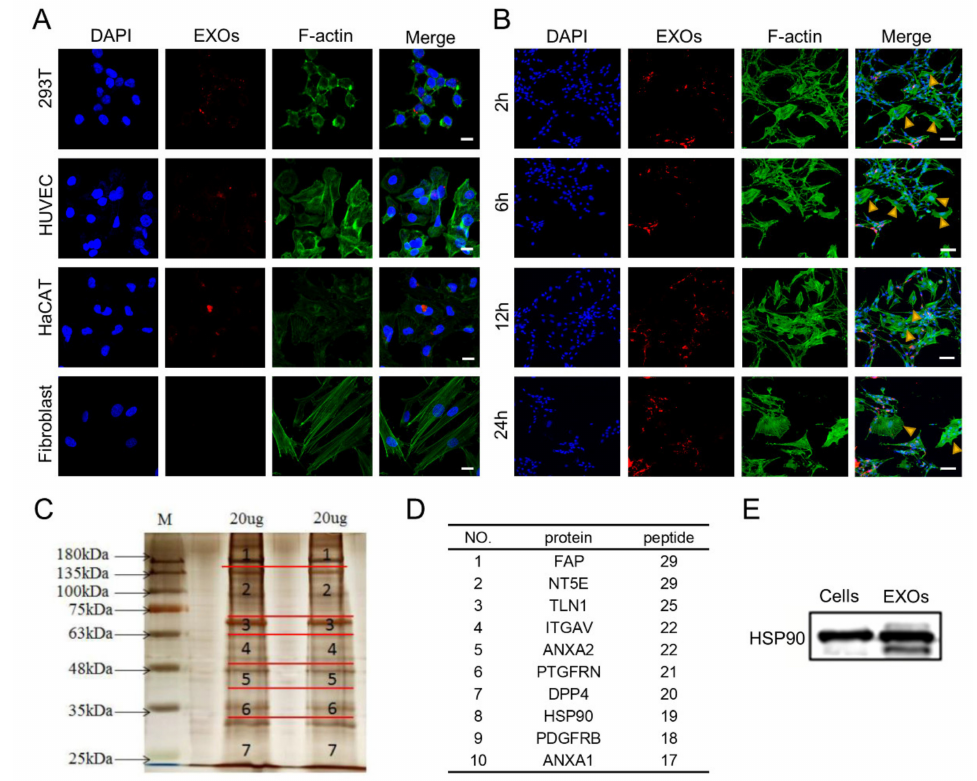
Figure 2. Internalization and protein analysis of ADSC-EXOs. ( A ) Confocal images of 293T, HaCAT, HUVECs, and fibroblasts incubated with 20 µ g PKH26-labeled ADSC-EXOs for 24 h; scale bar: 20 µ m. ( B ) Confocal images of co-cultured Schwann cells and fibroblasts incubated with PKH26-labeled ADSC-EXOs at different times; scale bar: 100 µ m. ( C ) Silver staining analysis of ADSC-EXOs protein gels. ( D ) Illustration of the top ten high-abundance surface proteins in ADSC-EXOs. ( E ) Western blot analysis of HSP90 levels in ADSCs and